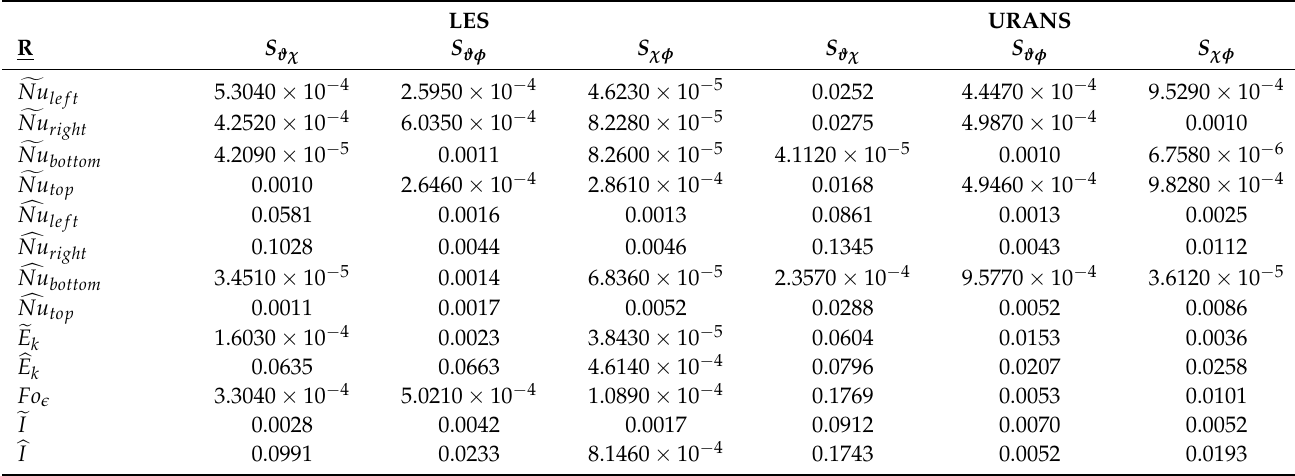
for the random response R . i q j